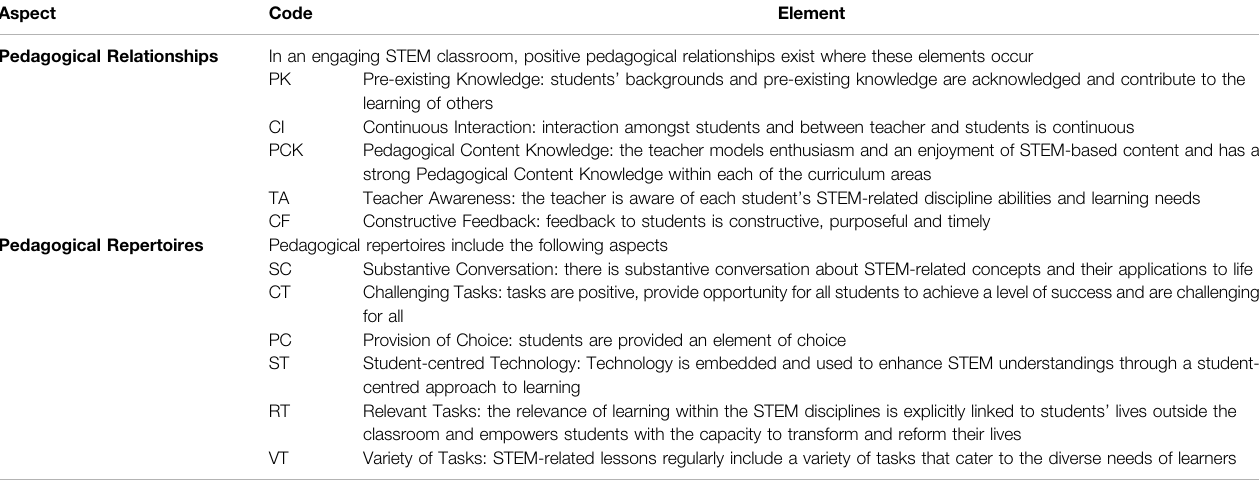
TABLE 1 | Framework for Engagement with STEM (adapted from the Framework for Engagement with Mathematics, Attard, 2014). Aspect Code Element Pedagogical